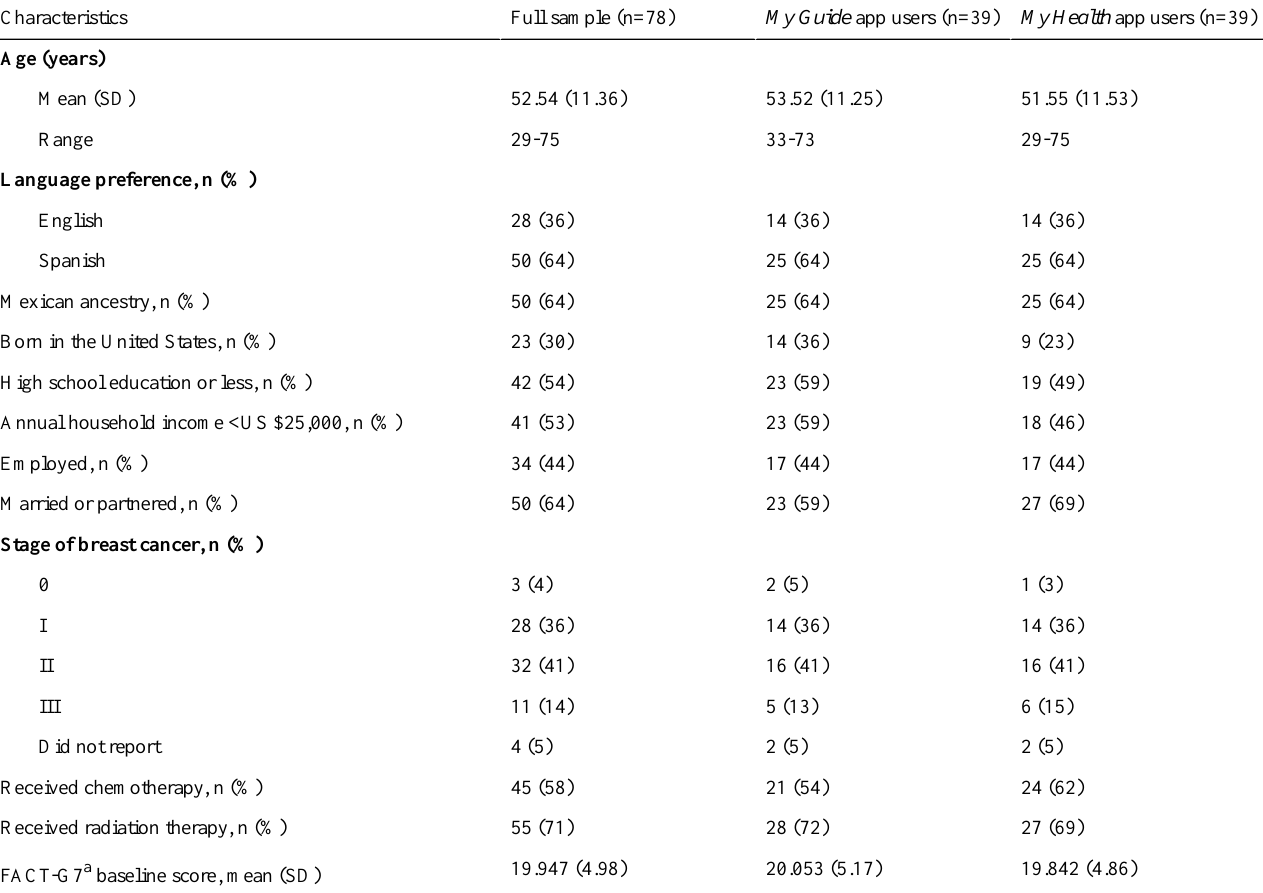
Table 1. Baseline sociodemographic and clinical characteristics.